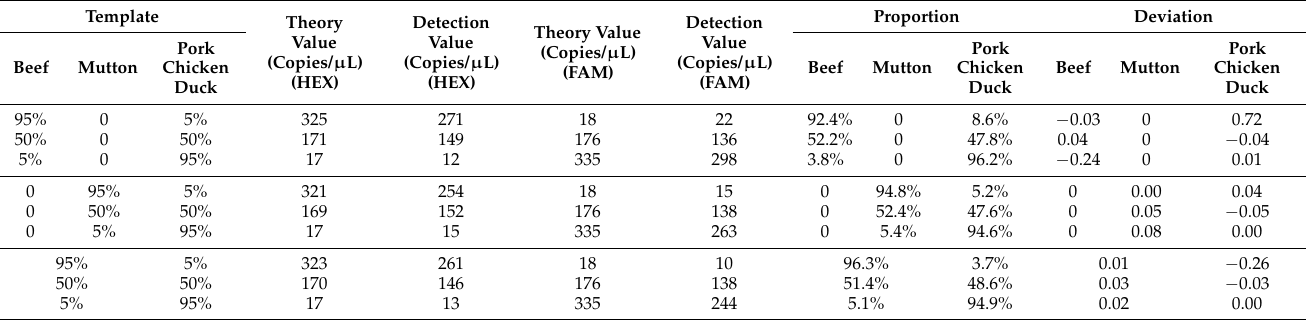
Table 7. Measured values of ddPCR for five